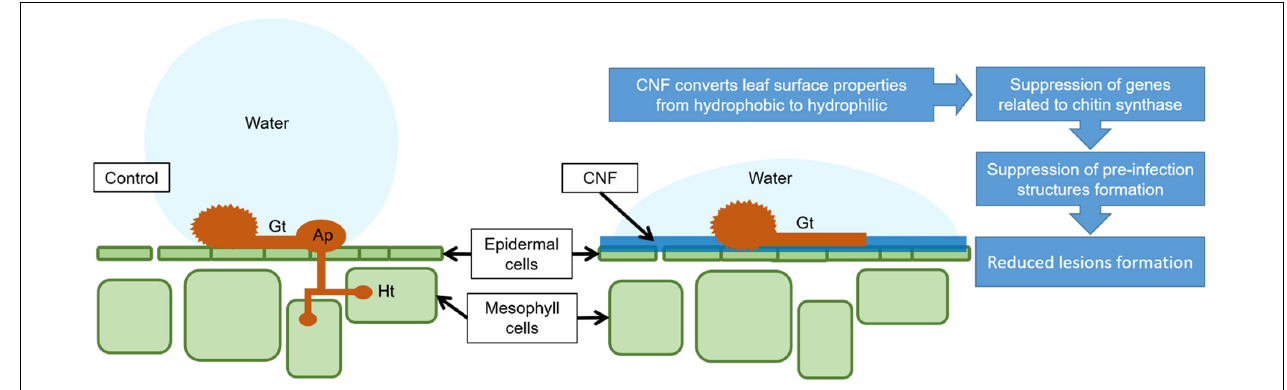
FIGURE 6 | Proposed mechanism model by which CNF-treatments confer resistance against P. pachyrhizi . CNF-treatments convert leaf surface properties from hydrophobic to hydrophilic. The formation of pre-infection structures, and the associated gene expressions related to these formations are suppressed on CNF-treated leaves, resulting in reduced P. pachyrhizi infection. Gt, Ap, and Ht show germ-tubes, appressoria, and haustoria,